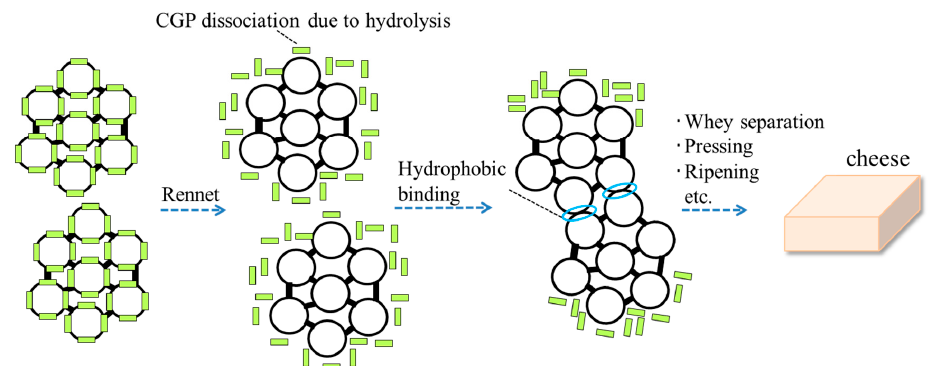
Figure 7. The mechanism of cheese curdling.